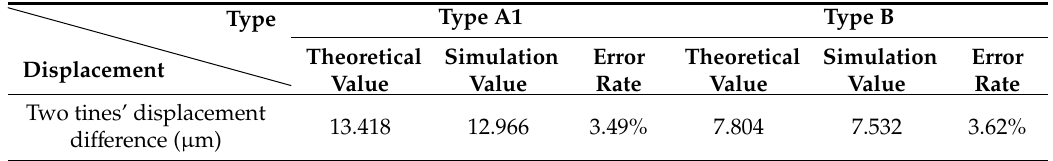
Table 4. Comparisons with theoretical and simulation values of types A1 and B.